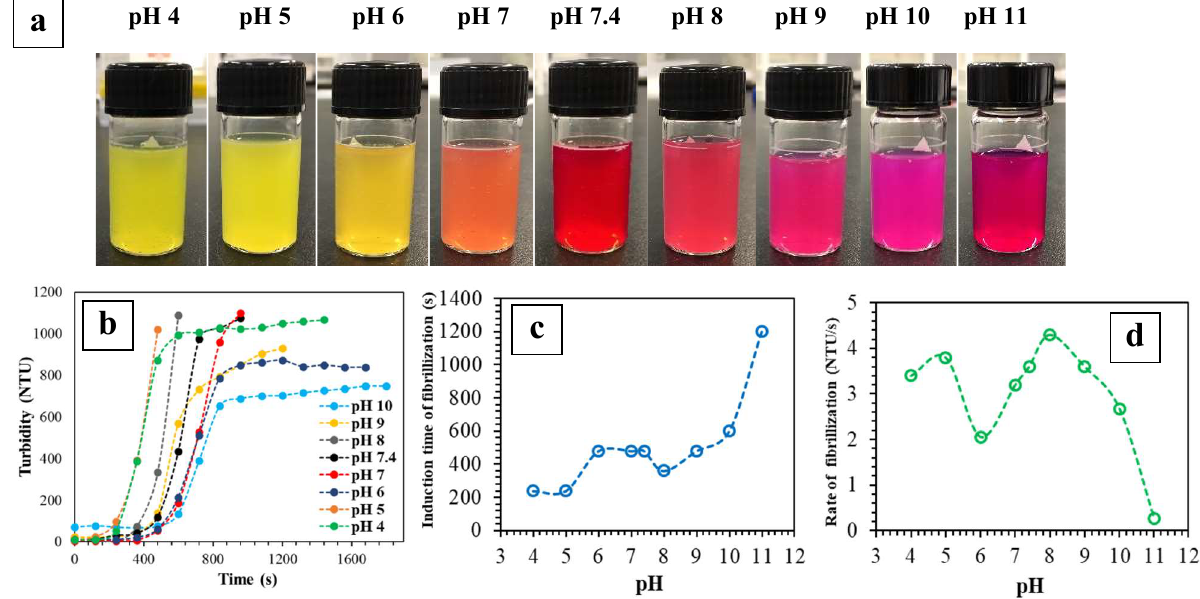
Figure 1. Turbidity measurement of collagen gelation: ( a ) Collagen solutions with various pH. Images were acquired immediately after the various collagen/MEM/NaOH solutions were prepared. ( b ) Change in turbidity of collagen solutions of various pH values as a function of time at 37 ◦ C (note that the curve of pH 11 could not be presented here along with other curves due to its long gelation). The upper limit of the turbidimeter used here was 1100 NTU. ( c ) Induction time, and ( d ) rate of fibrillization as a function of pH generated from the corresponding turbidity-time graphs ( n =